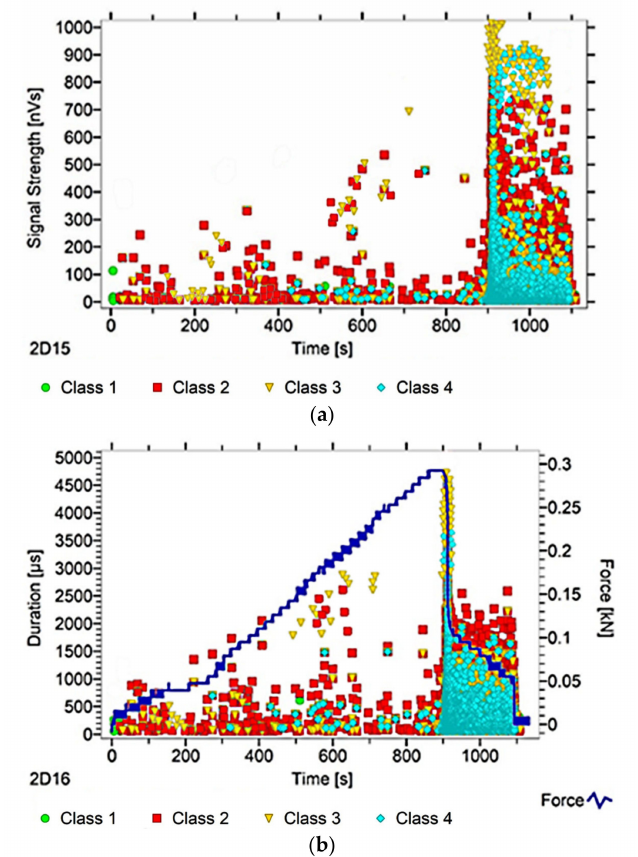
Figure 3. AE signal graphs for the mock BS sample: ( a ) signal strength distribution in time; ( b ) signal duration distribution in time, with plotted force increment curve.